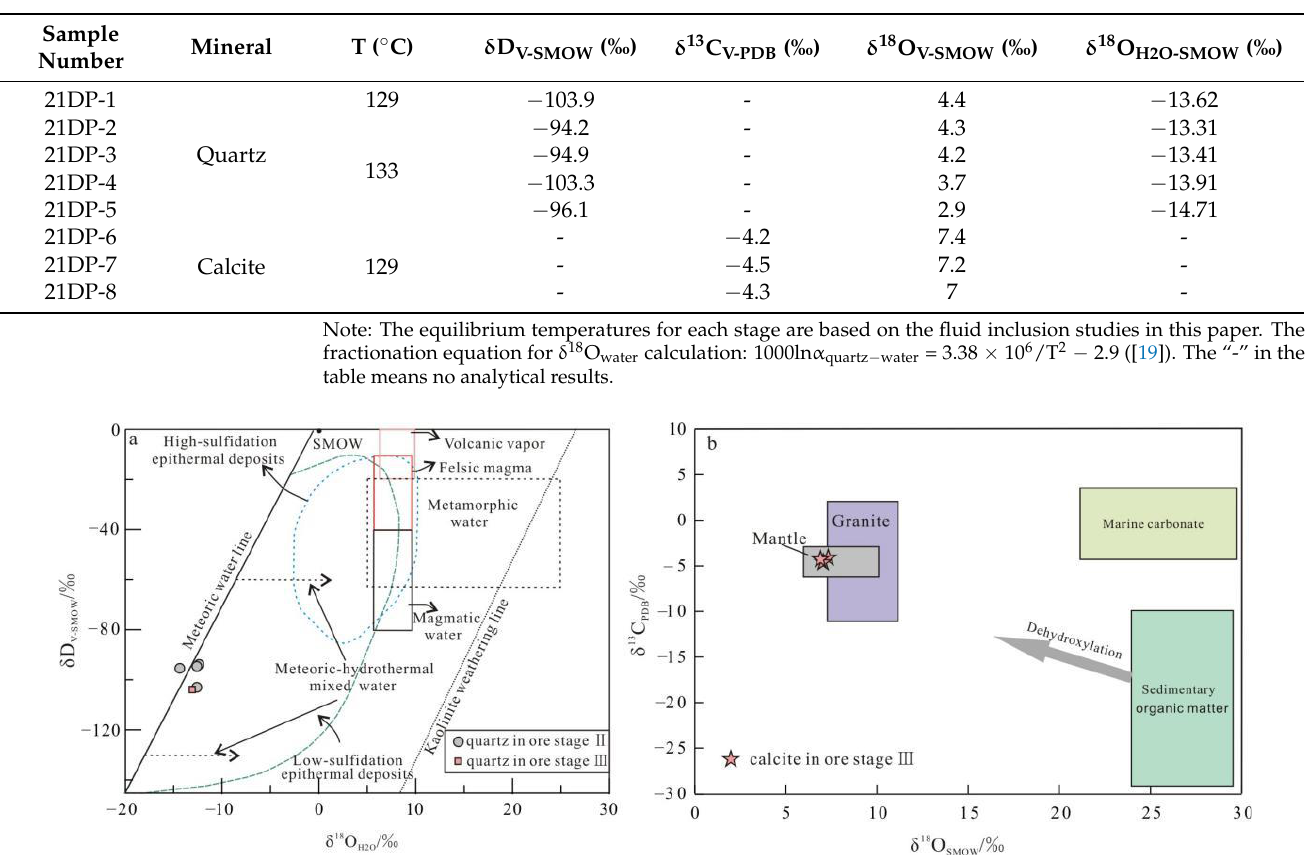
Table 3. C – H – O isotope data of the Dongpuzi gold deposit. Table 3. C–H–O isotope data of the Dongpuzi gold deposit.